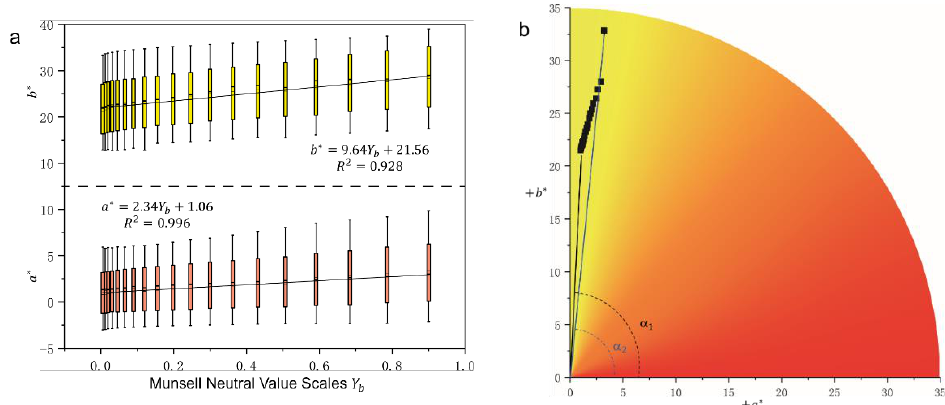
Figure 9. ( a ) Changes in colorimetric coordinates 𝑎 ∗ and 𝑏 ∗ with different backgrounds. Data are shown in Supplementary Materials Tables S5 and S6. ( b ) The 𝑎 ∗ and 𝑏 ∗ cast-point that can explain the decreasing Hue. α 1 is the mean angle of all the sample on N0.5 while α 2 represents the